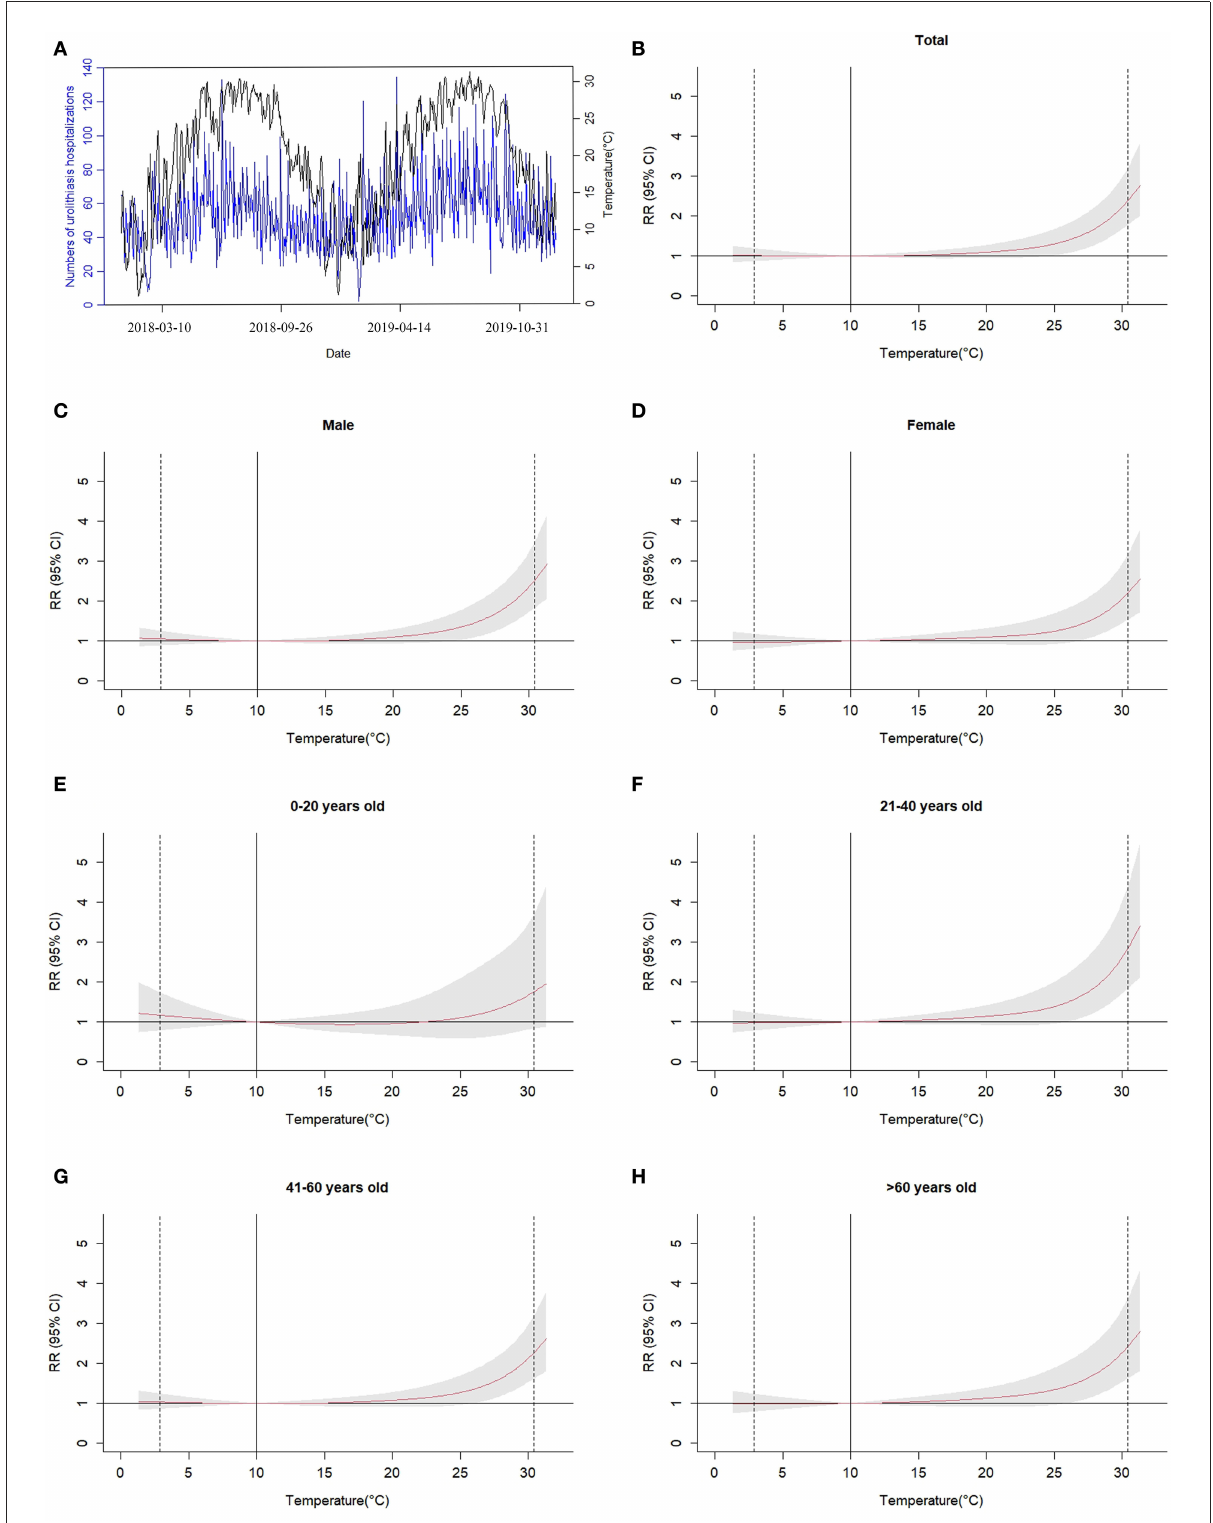
FIGURE1 Temporal trend (A) and effect curves (B–H) of the daily mean temperature on the number of inpatients with urolithiasis in Ganzhou City during the 10 days lag period, relative to 10 ◦ C. The vertical solid line at 10 ◦ C represented the reference temperature. The two vertical dotted lines represent P1 (2.9 ◦ C) and P99 (30.4 ◦ C) of the daily mean temperature, respectively. The red curve was RR, and the surrounding gray area was 95%